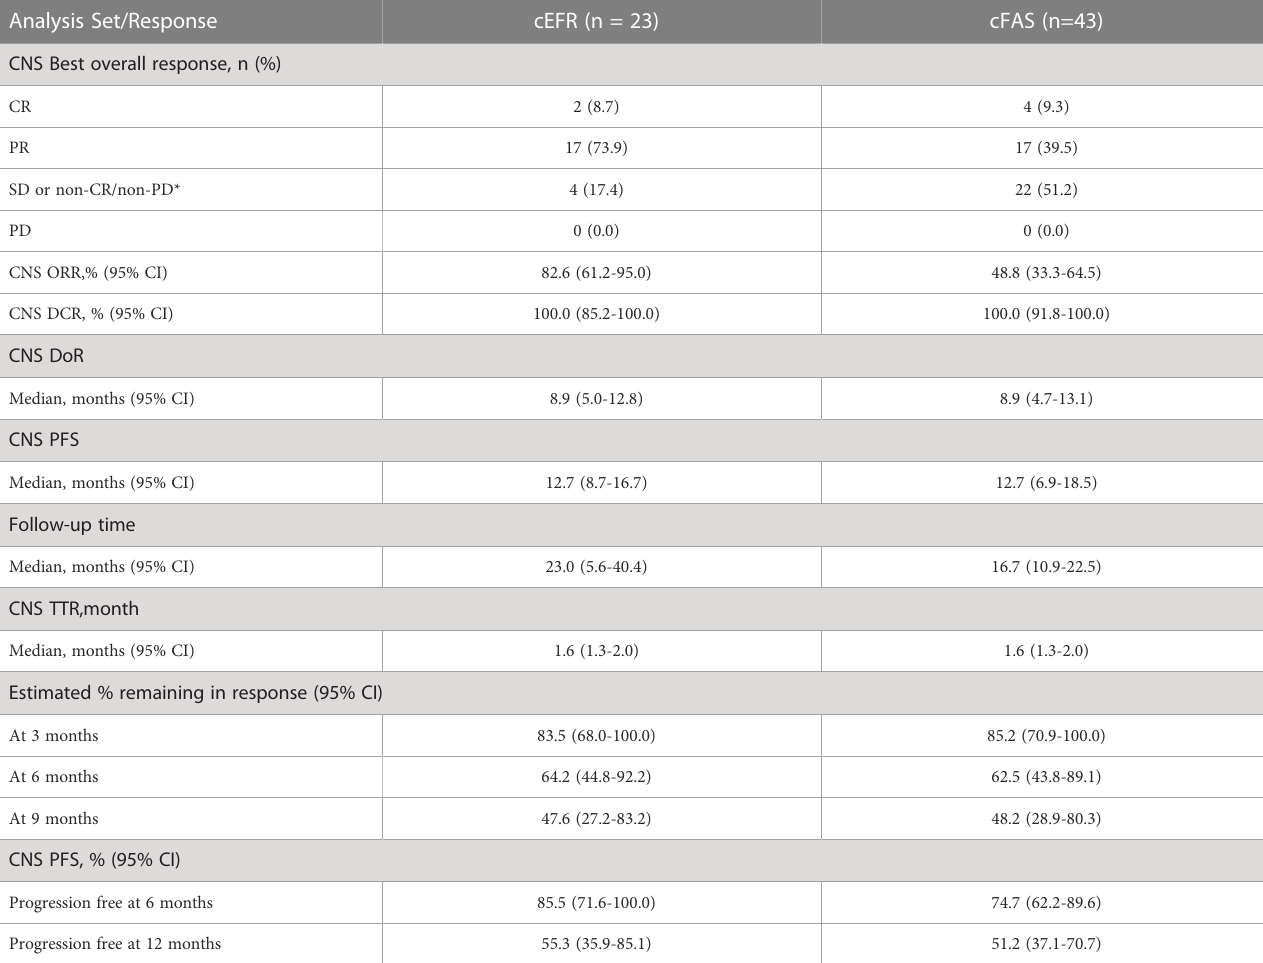
TABLE 2 CNS activity of afatinib in patients with brain metastases. Analysis